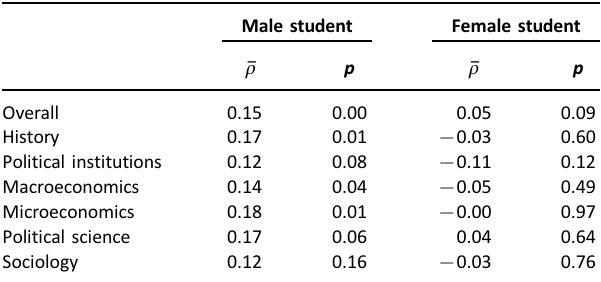
only one field (Political Science), but in no case statistically